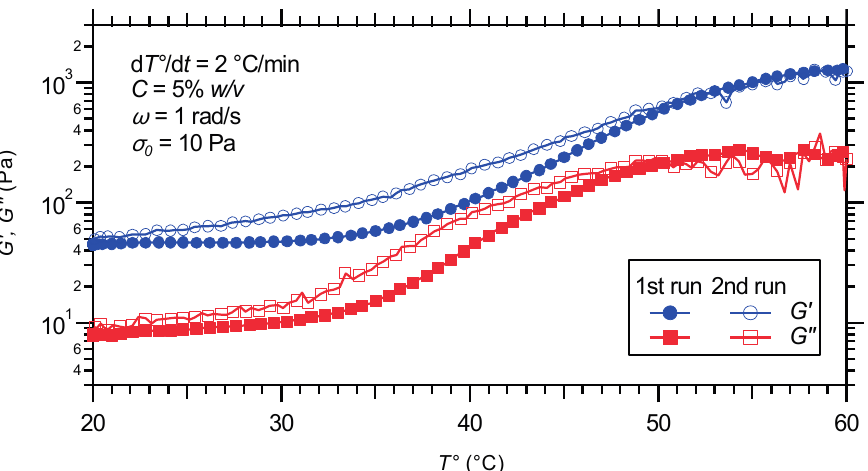
Figure 7. Temperature dependence of dynamic moduli for a hydrogel prepared from the PS- b -PNIPAAm- b -PDMAEMA-tpy copolymer and Ni(II) ions: first run upon heating; second run upon